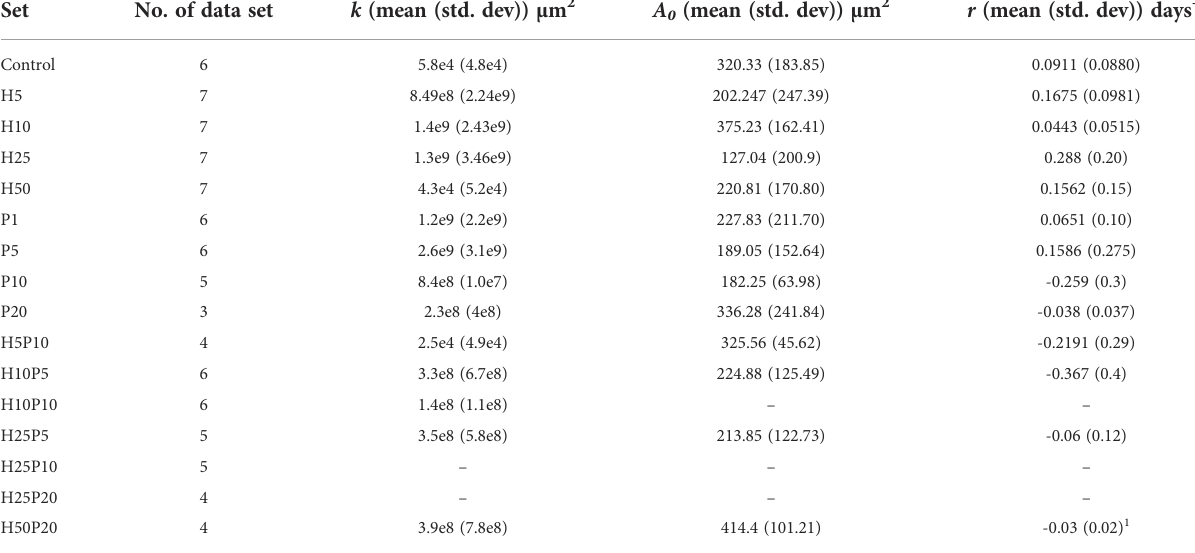
TABLE 1 Gompertz model parameters for the growth of the ZR75 colonies in agar assay.